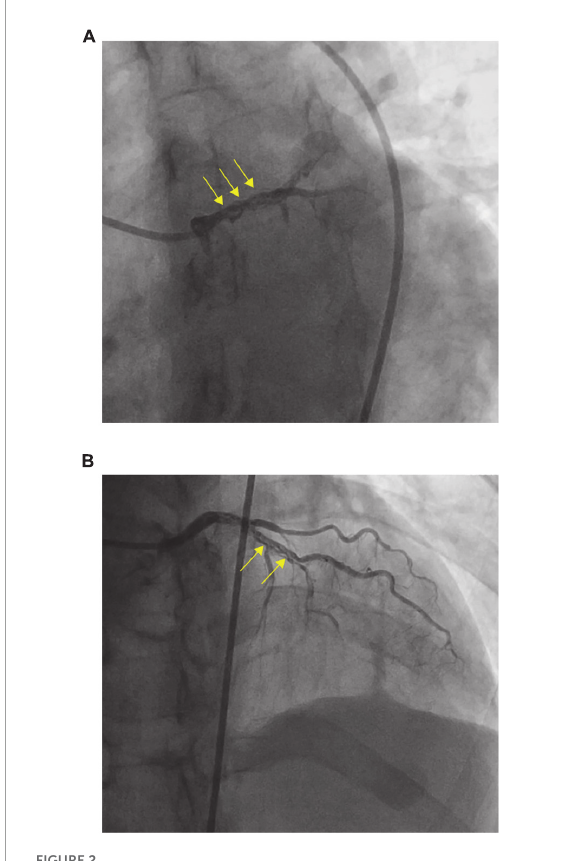
FIGURE2 Coronary angiography (CAG) (A,B) revealed woven coronary artery